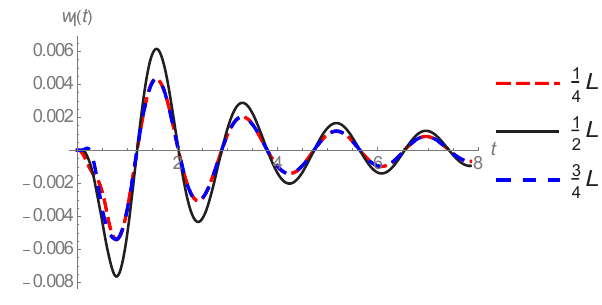
Figure 2: Deflection of the structure. An absorber with parameters μ =0.05, κ